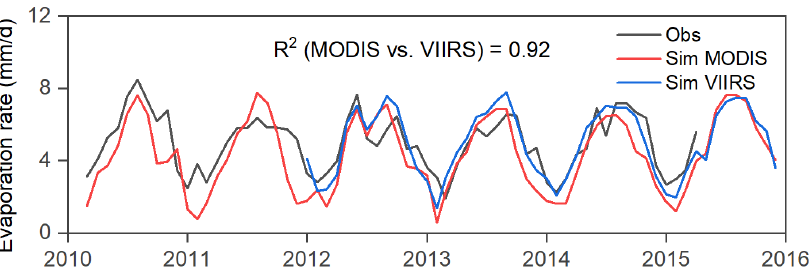
Figure 10. Comparison of monthly evaporation rates for Lake Mead between MODIS and VIIRS.